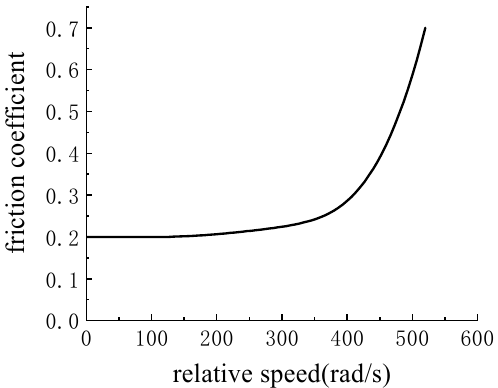
Figure 8. Friction coefficient and relative rotational speed curve [18,19].